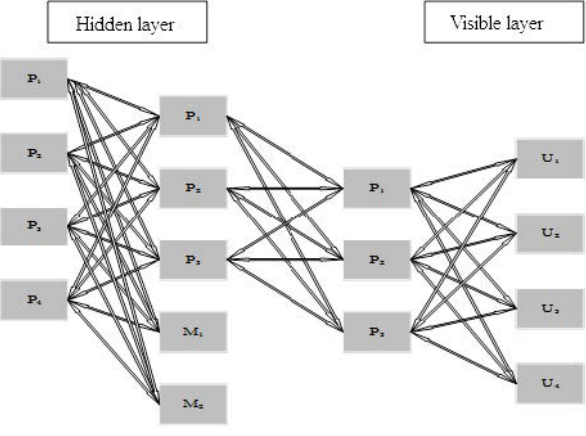
Fig. 3 DBN training framework. DBN: deep belief